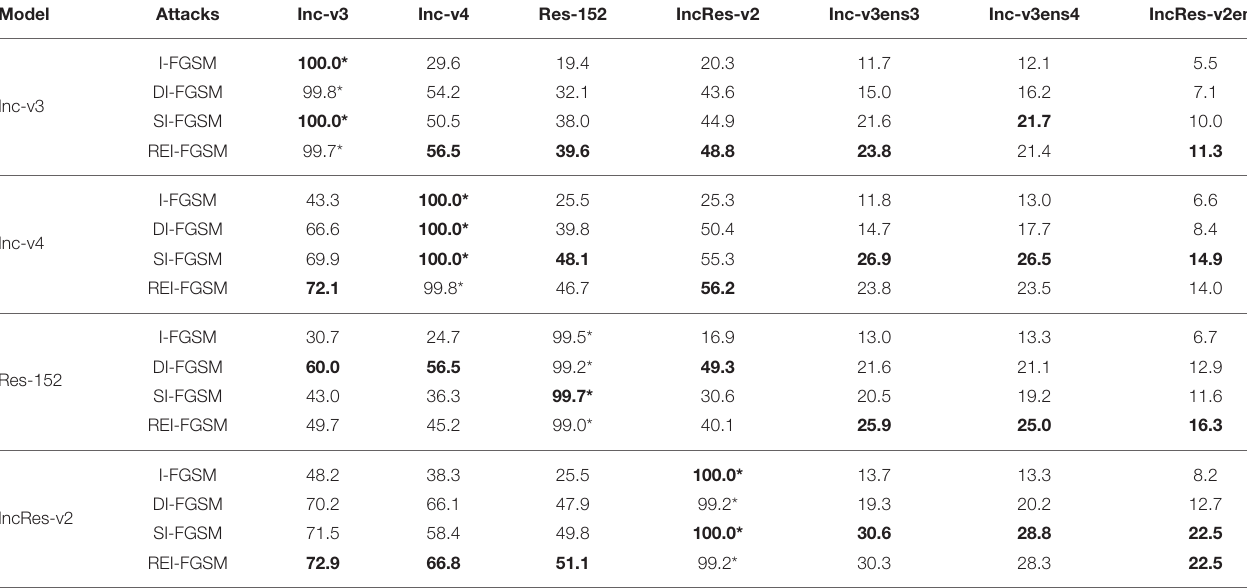
TABLE 2 | The success rate(%) of non-targeted attacks of seven models.